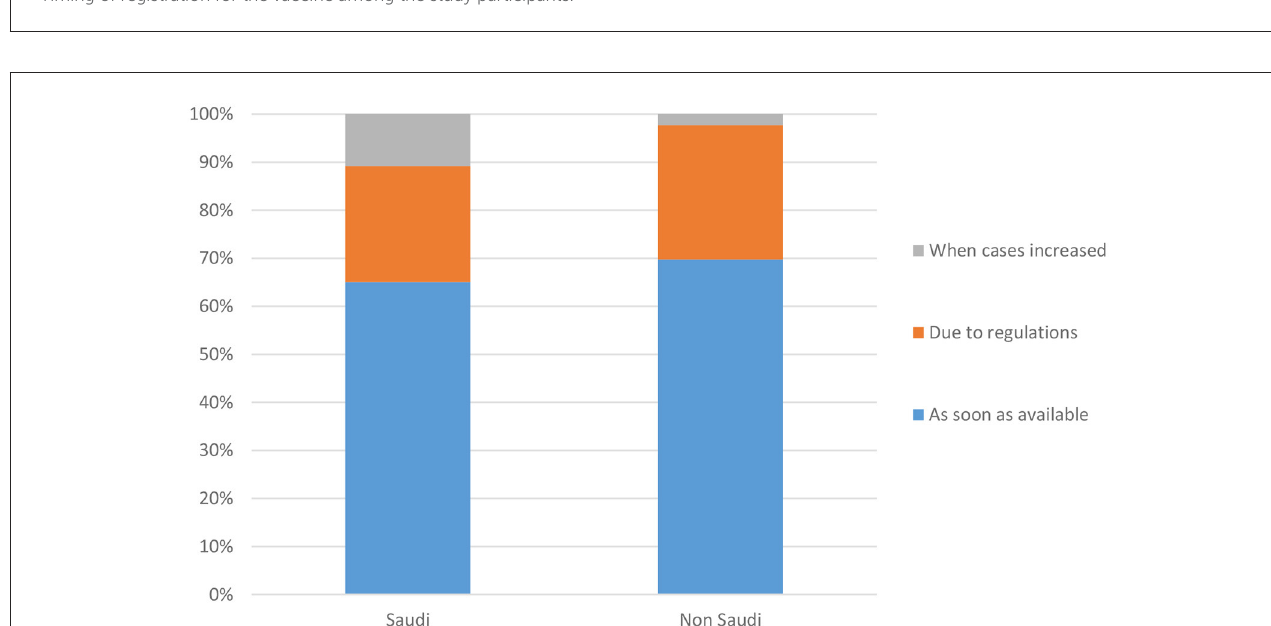
FIGURE2 Timing of registration for the vaccine among the study participants.